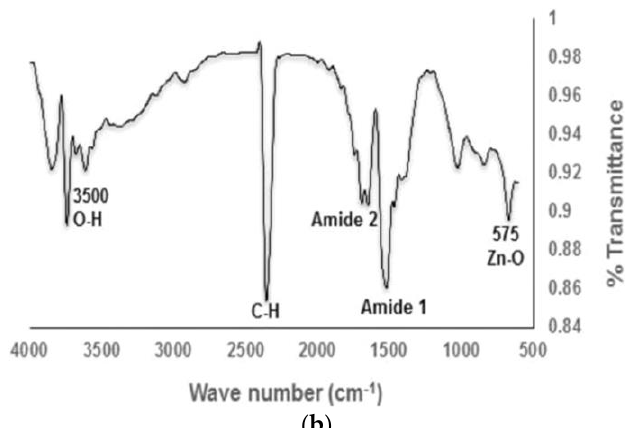
Figure 13. ( a ) X-ray diffraction pattern and selected area electron diffraction pattern (inset) of green ZnO nanoflowers (ZnONFs) showing the formation of a hexagonal wurtzite structure. Reproduced from [85] with permission of MDPI. ( b ) FTIR spectrum of biosynthesized ZnO NPs. Reproduced from [87]